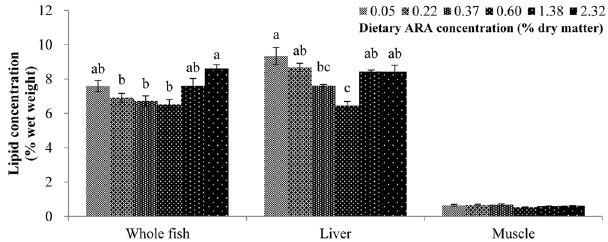
Figure 5. Lipid contents in experimental fish. Results are expressed as means ± standard error (n = 3). Different letters above the bars denote significant ( P < 0.05) differences among dietary